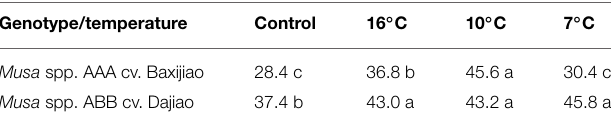
Values represent averages from three biological replicates. Different letters after values mean that they are significantly different using Duncan’s multiple range test at P < 0.05 after angular transformation of the